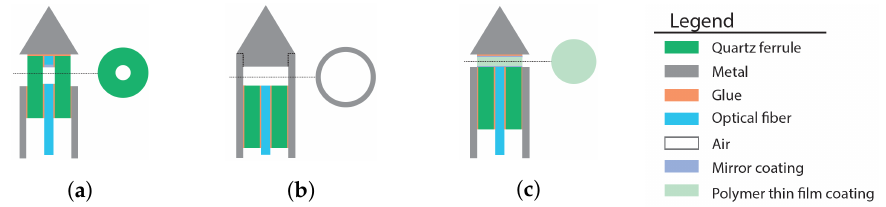
Figure 3. The three most promising concepts for a fiber-optic force sensor, based on Fabry-Pérot interferometry, in the tip of the stylet of a trocar needle to measure forces in axial direction on the needle tip, showing ( a ) the quartz capillary concept; ( b ) the Invar capillary concept; and ( c ) the thin flim concept. The illustrations of each concept show an axial cross-section of the stylet tip and a transverse cross-section of the stylet tip at locations containing an FPI